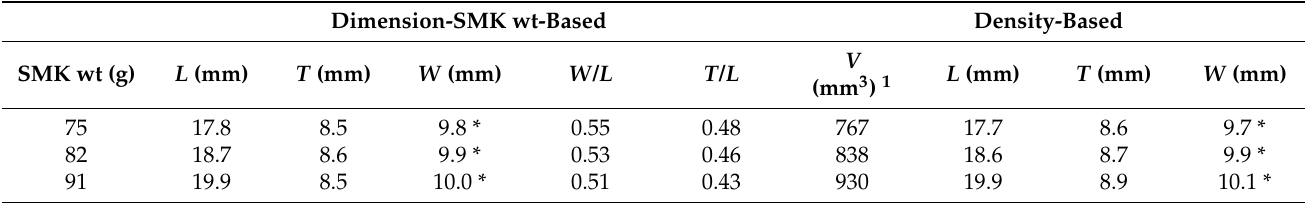
Table 4. Length ( L ), thickness ( T ), width ( W ), and aspect ratios for width ( W / L ) and thickness ( T / L ) estimated for selected extra large seeded runner market type sizes as linear functions of sound mature kernel (SMK) wt or